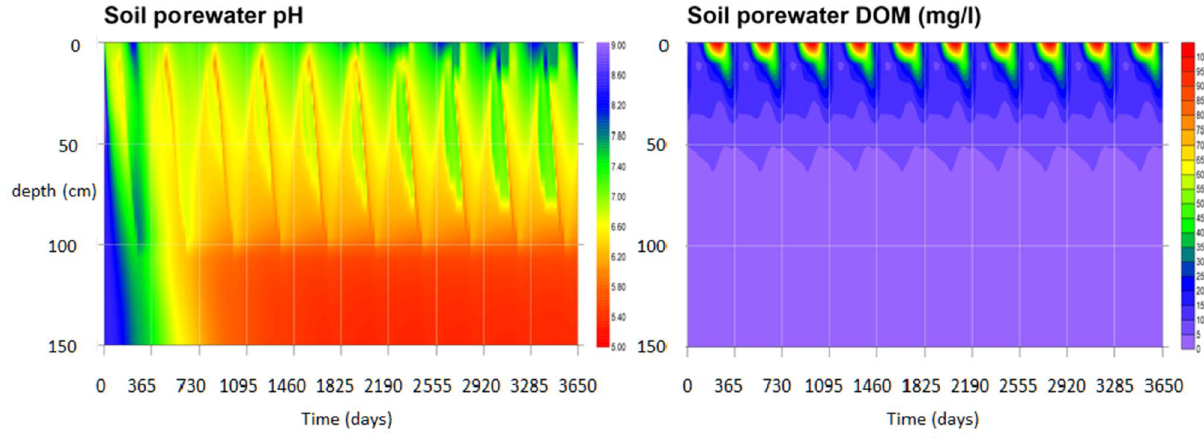
ied between 110 mg/l during summer in the upper 10 cm of the profile, to < 5 mg/l for the intermediate (> 50 cm) and deeper (> 100 cm) part of the soil profile during the whole